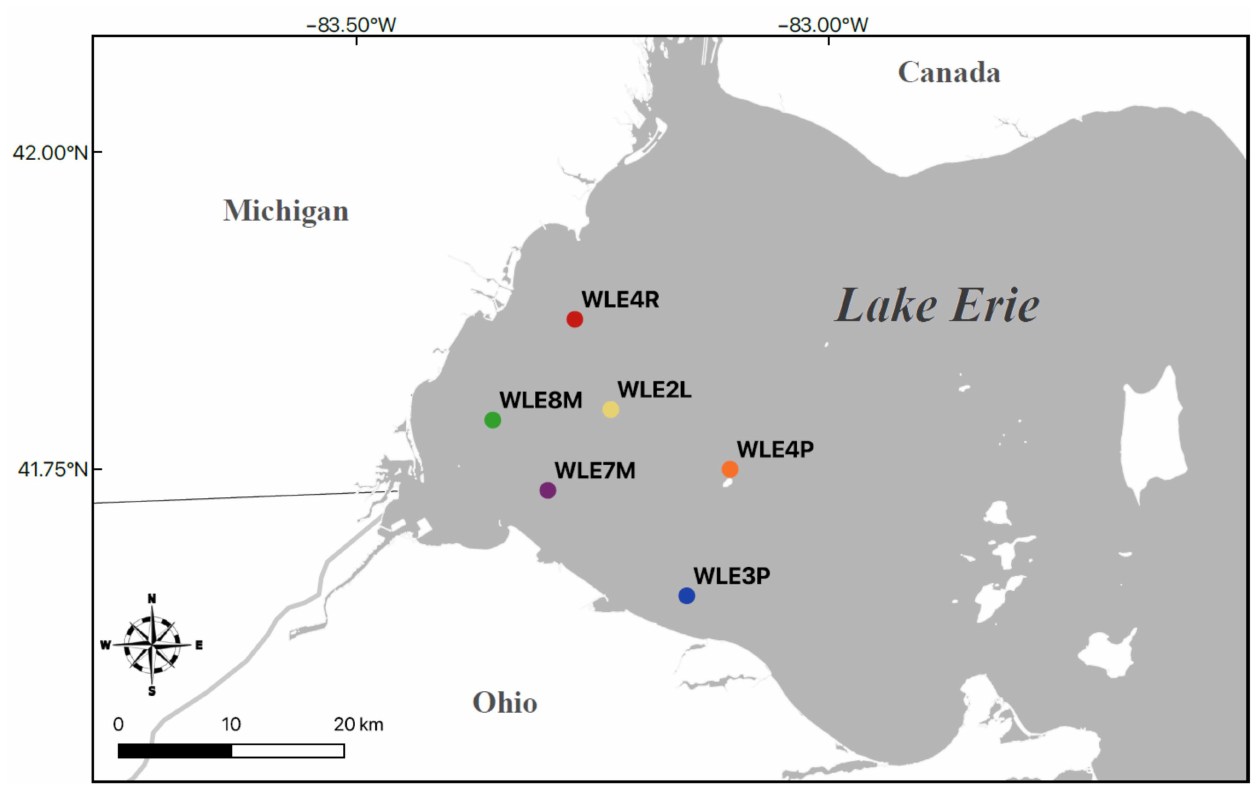
Figure 1. Map of western Lake Erie displaying the six sampling sites for eDNA water